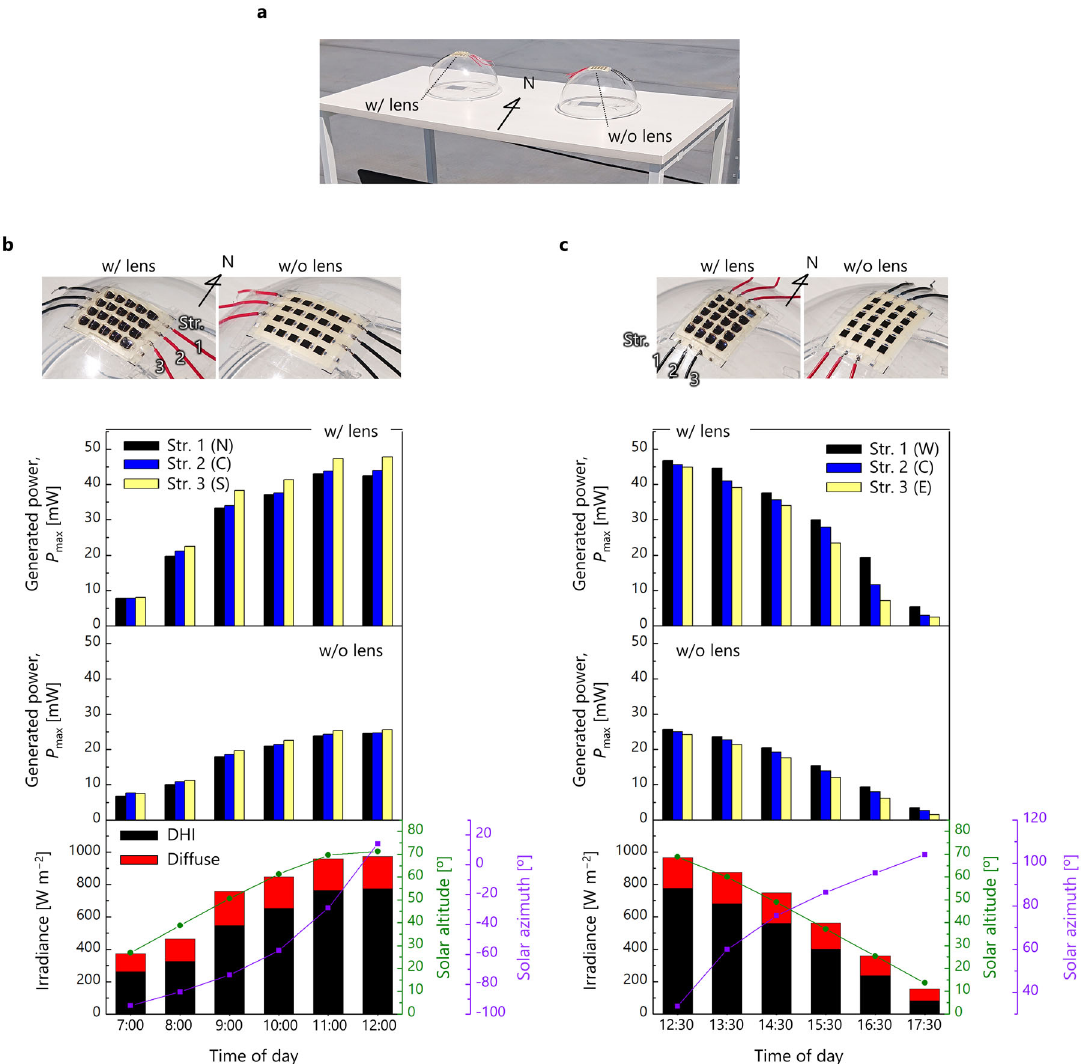
Fig. 4 Outdoor power-generation performance at representative times (prototype modules atop the hemispherical domes were installed on a horizontal surface). a Magni fi cations of the prototype modules in the experimental setup. b , c Measured P max and irradiances (direct horizontal irradiance (DHI), diffuse irradiance) as a function of the sun ’ s position on May 17, 2019 (Nagaoka city, Japan). String directions were ( b ) east – west in AM and ( c ) north – south in PM. String 1 lay on the northern side in AM (black bar referred to as “ N ” ) and on the western side in PM (black bar referred to as “ W ” ); string 2 lay on the center line of the hemispherical dome (blue bar referred to as “ C ” ); and string 3 lay on the southern side in AM (yellow bar referred to as “ S ” ) and on the eastern side in PM (yellow bar referred to as “ E ” ). For the solar altitude, 90° corresponded to the zenith, and for the solar azimuth, − 90°, 0°, and 90° corresponded to the east, south, and west, respectively. (w/ lens, with lens; w/o lens, without